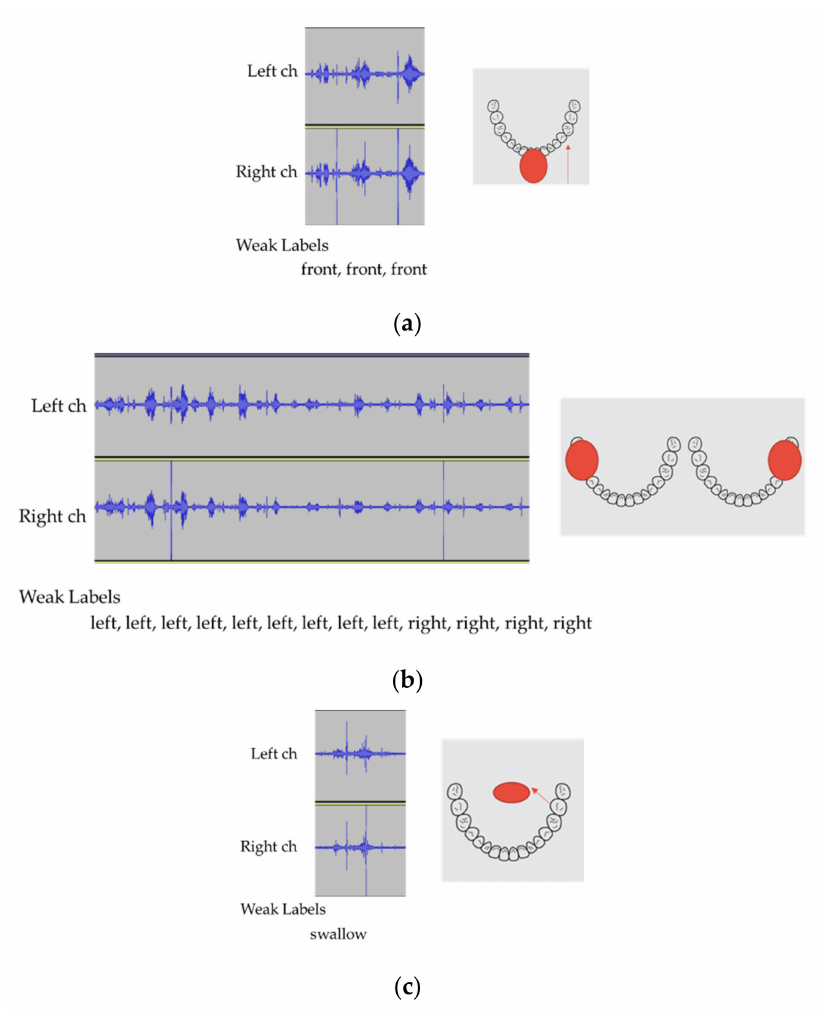
Figure 5. Motion for eating one cracker ( a ) front biting, ( b ) left and right chewing, and ( c ) swallowing.